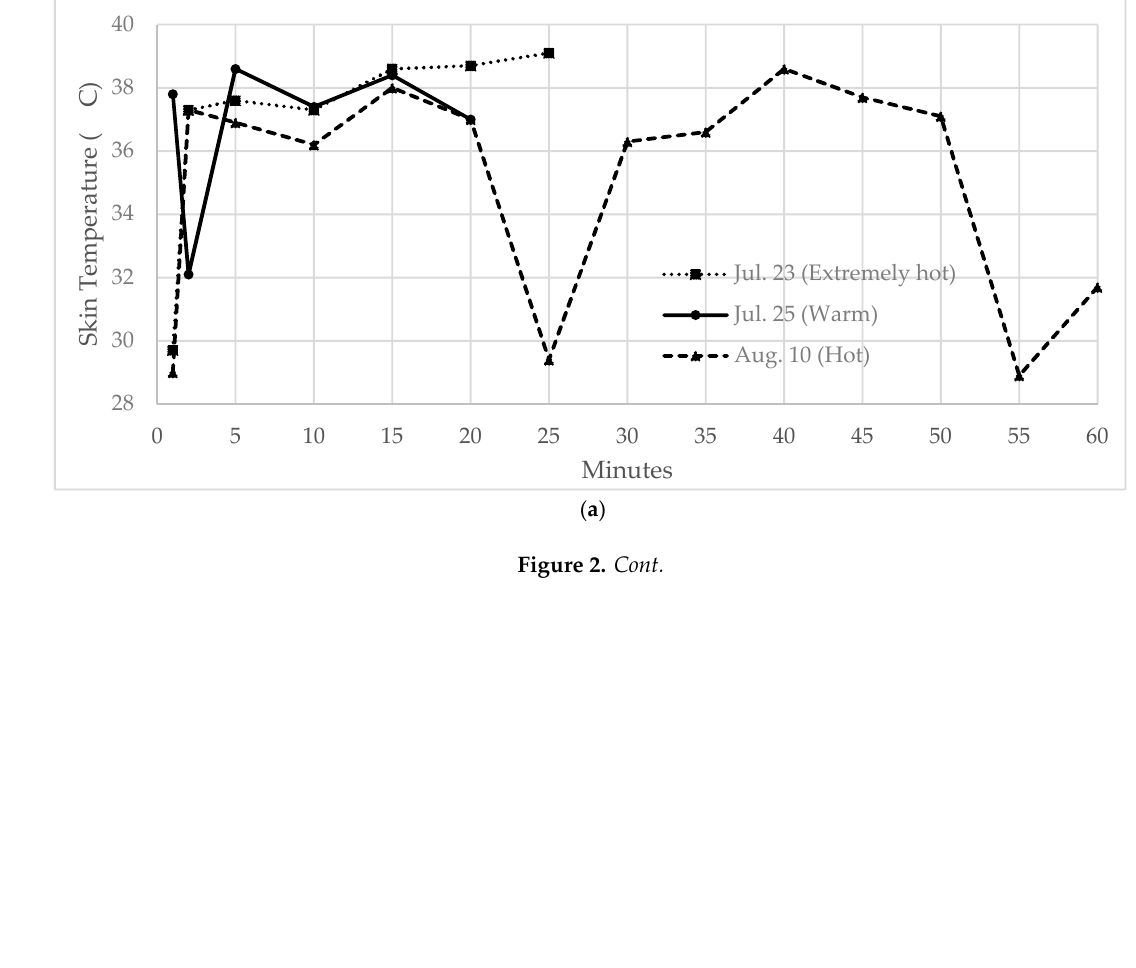
Table 6. Summary of procedure results. Columns show the 12 procedures with recorded facial skin temperatures (average of five points: Ear, cheek, nose, chin, and temple) collected every 5 min. Rows represent participants’ self-reported thermal comfort levels collected every 15 min.